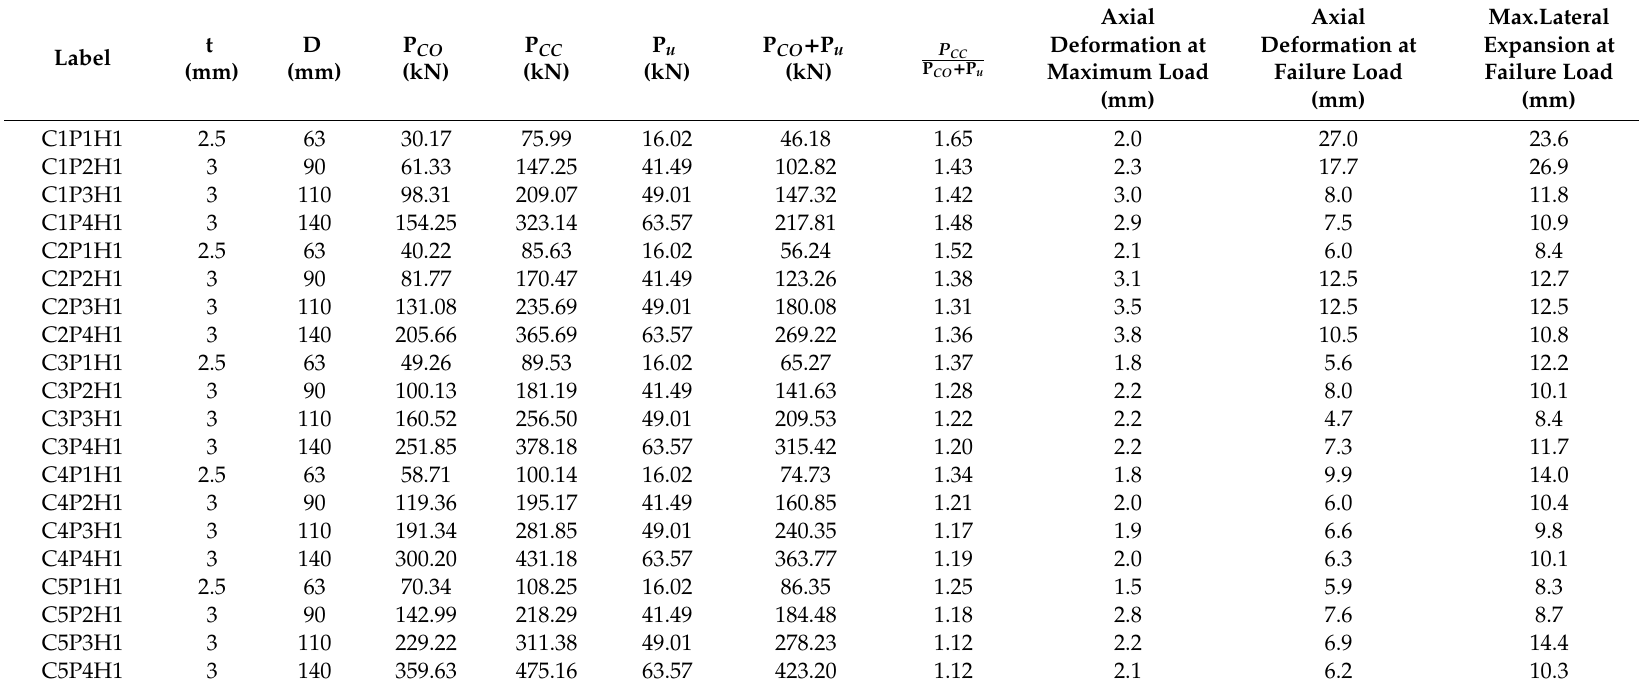
Table 6. Average Maximum Values of Load Carrying Capacity and